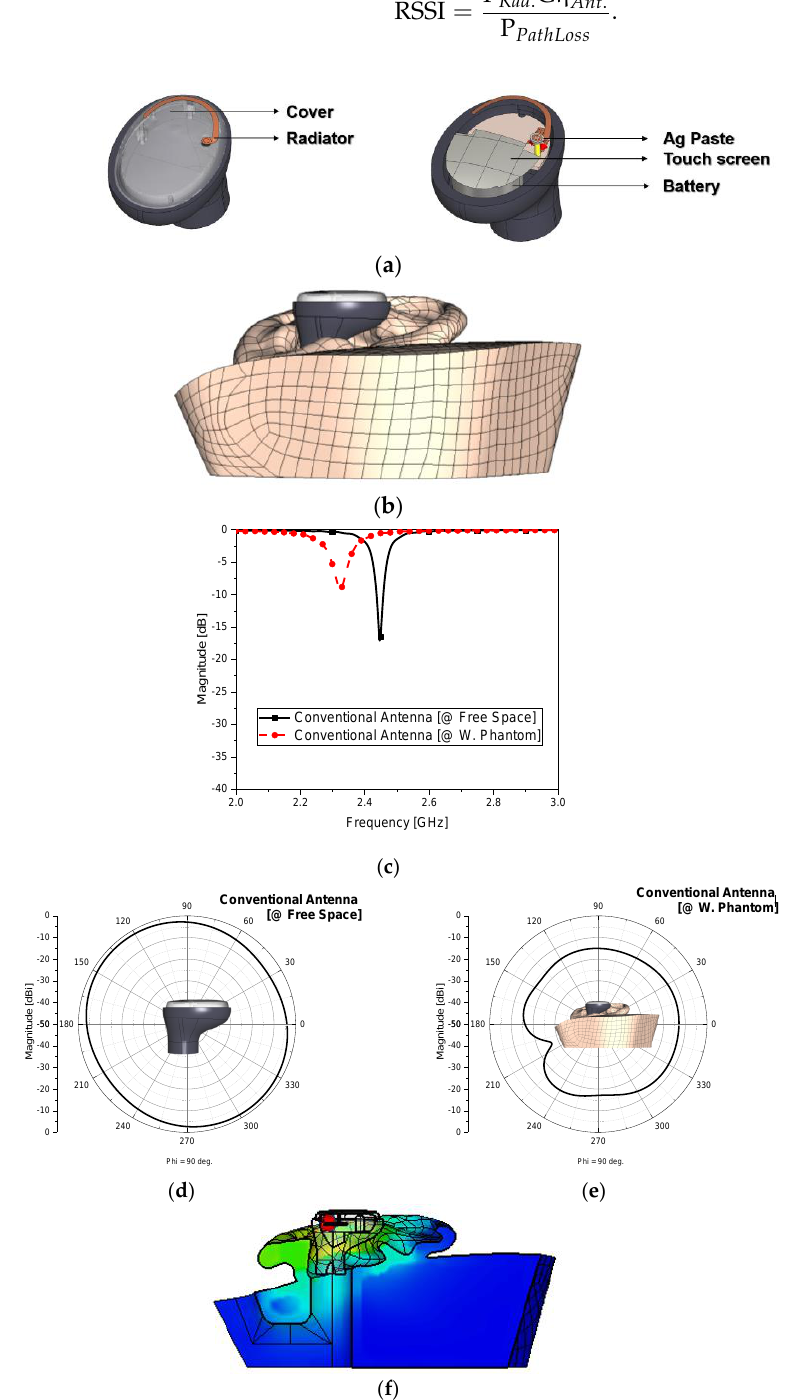
Figure 2. Investigating the conventional antenna: ( a ) geometry; ( b ) attached to the human phantom; ( c ) S 11 ; ( d ) radiated field pattern of the modified monopole antenna in the free space; ( e ) radiated field pattern of the modified monopole antenna with the phantom; ( f )